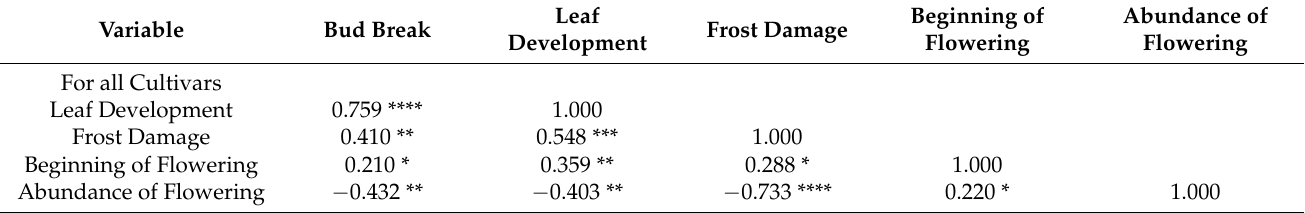
Table 11. Correlations matrix between frost damage, early phenology stages, and beginning and abundance of flowering in climber roses for all cultivars taken together (‘Alberic Barbier’, ‘Albertine’, ‘Chaplin’s Pink Climber’, ‘Dr Robert Huey’, ‘Duc de Constantin’, ‘Gerbe Rose’, ‘Mme Plantier’, ‘Orange Triumph clg’, ‘Paul Scarlet Climber’, ‘Venusta Pendula’, and ‘Z é phirine Drouhin’). Beginning of Abundance of Frost Damage Flowering Flowering Development